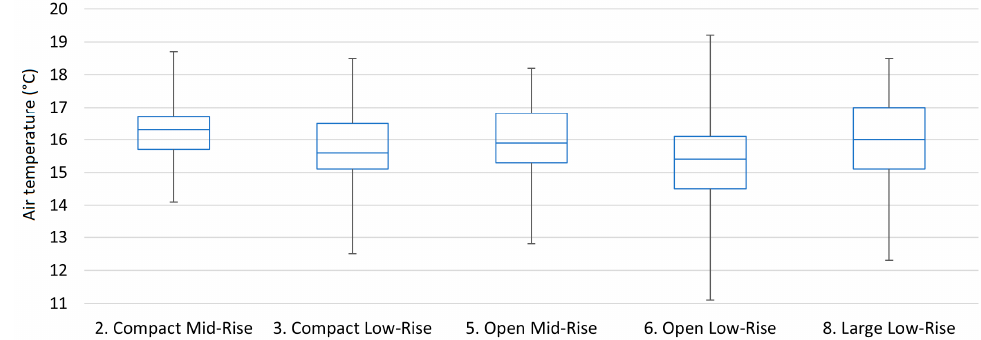
Figure 10. Boxplots representing the air temperature distribution per LCZ class (considering all the observations available in the period 2018–2021).